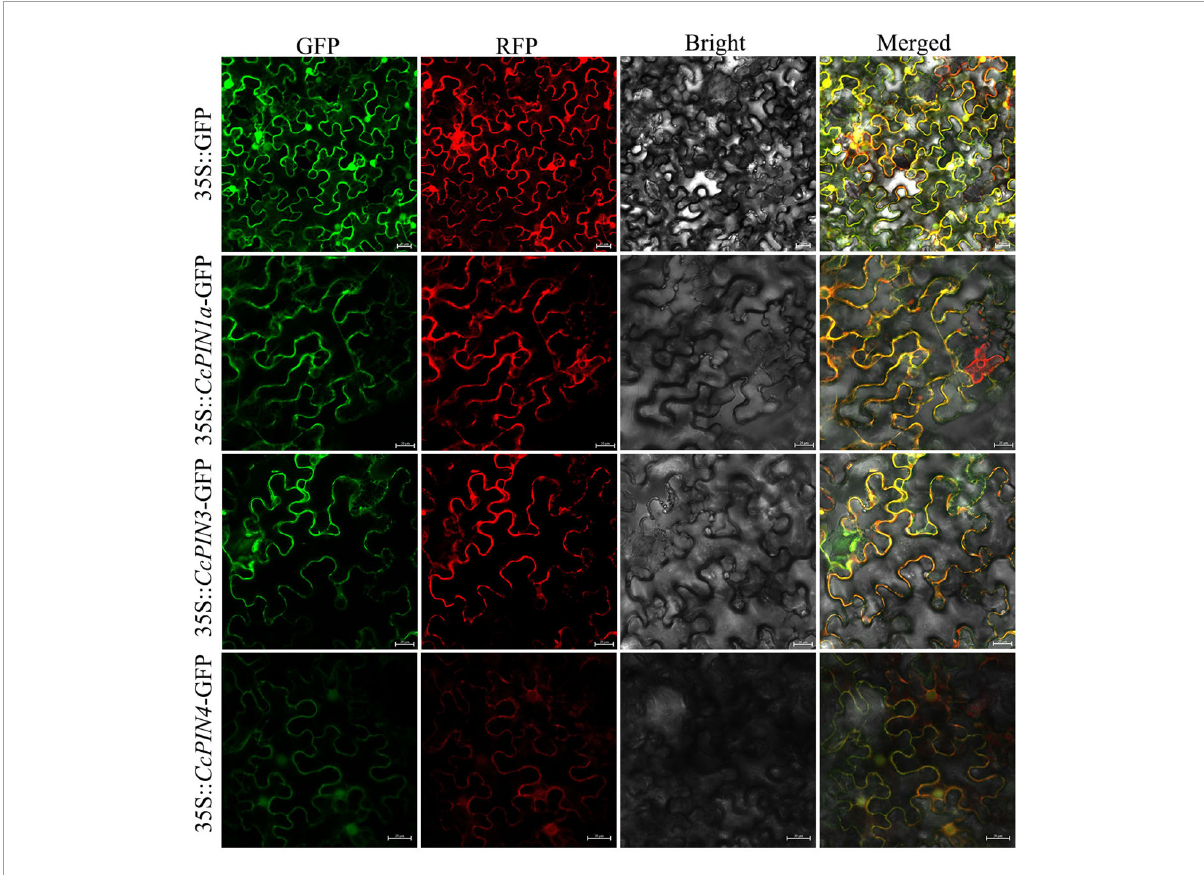
FIGURE1 The subcellular localization of CcPIN1a, CcPIN3, and CcPIN4. The fluorescence images were captured in a dark field for green and red fluorescence, in a white field for the morphology of the cell, and in combination. GFP, green fluorescent protein fluorescence; RFP, red fluorescent protein fluorescence; Bright, bright field; Merged, GFP/RFP/bright field overlay. Bar = 20 µ